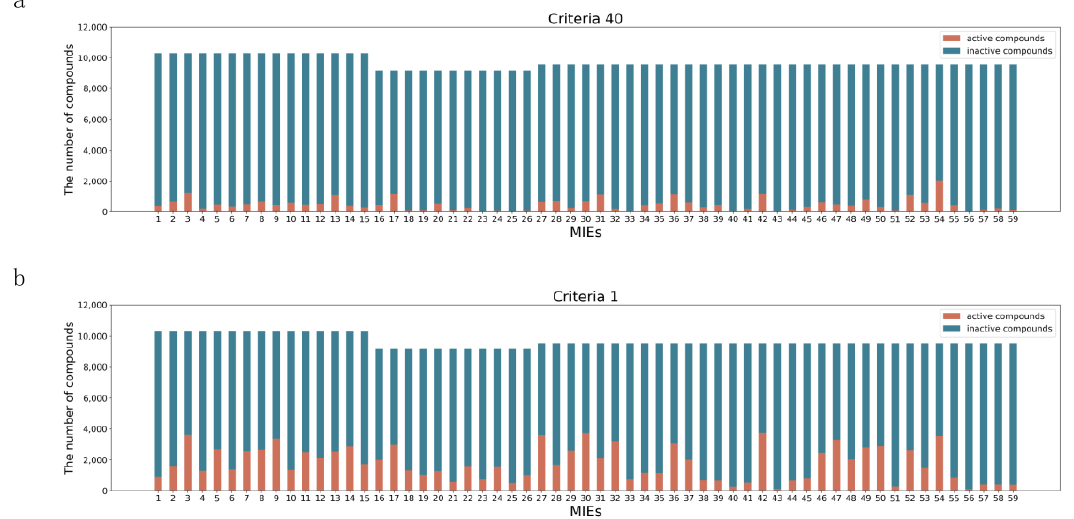
Figure 1. Activity distribution of 59 molecular initiating events (MIEs) in the Tox21 10K library: ( a ) the number of chemical compounds in the case of criteria 40 and ( b ) the number of chemical compounds in the case of criteria 1. Orange and blue show active and inactive chemicals, respectively.